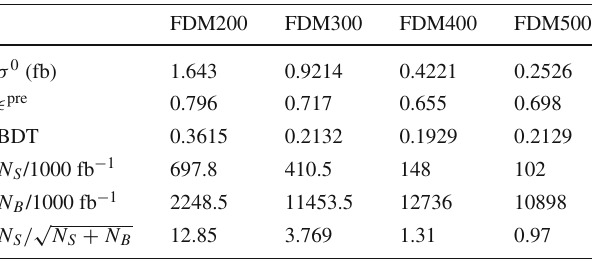
Table 3 The total production cross section ( σ 0 ), cross section after pre-selection ( (cid:18) pre ), the chosen BDT cut (BDT), number of signal ( N S ) and background ( N B ) events after BDT cut and the signal significance ( N